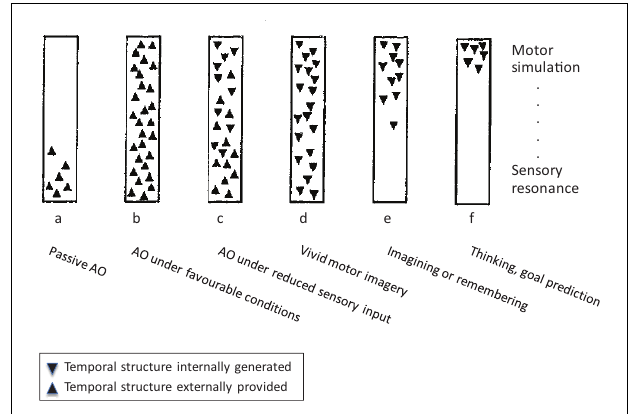
FIGURE 1 | The continuum between action observation and motor imagery, modified from Shepard (1984), for details see text. Note: Whereas Shepard’s scheme encompassed a wider range of cognitive processes, we focus on AO and MI. In addition, we have replaced Shepard’s ordinate of a “hierarchy of resonant modes” (from most concrete and sensory at the bottom to most abstract and conceptual at the top) by a sensory-motor